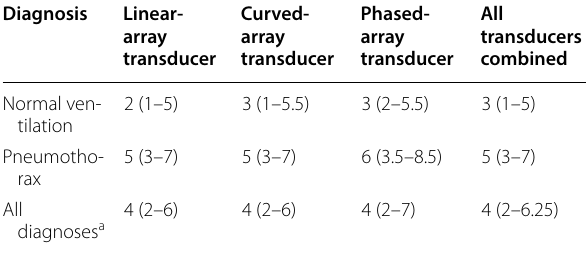
The data are presented as median seconds (interquartile range) a This includes the ten clips without diagnosis